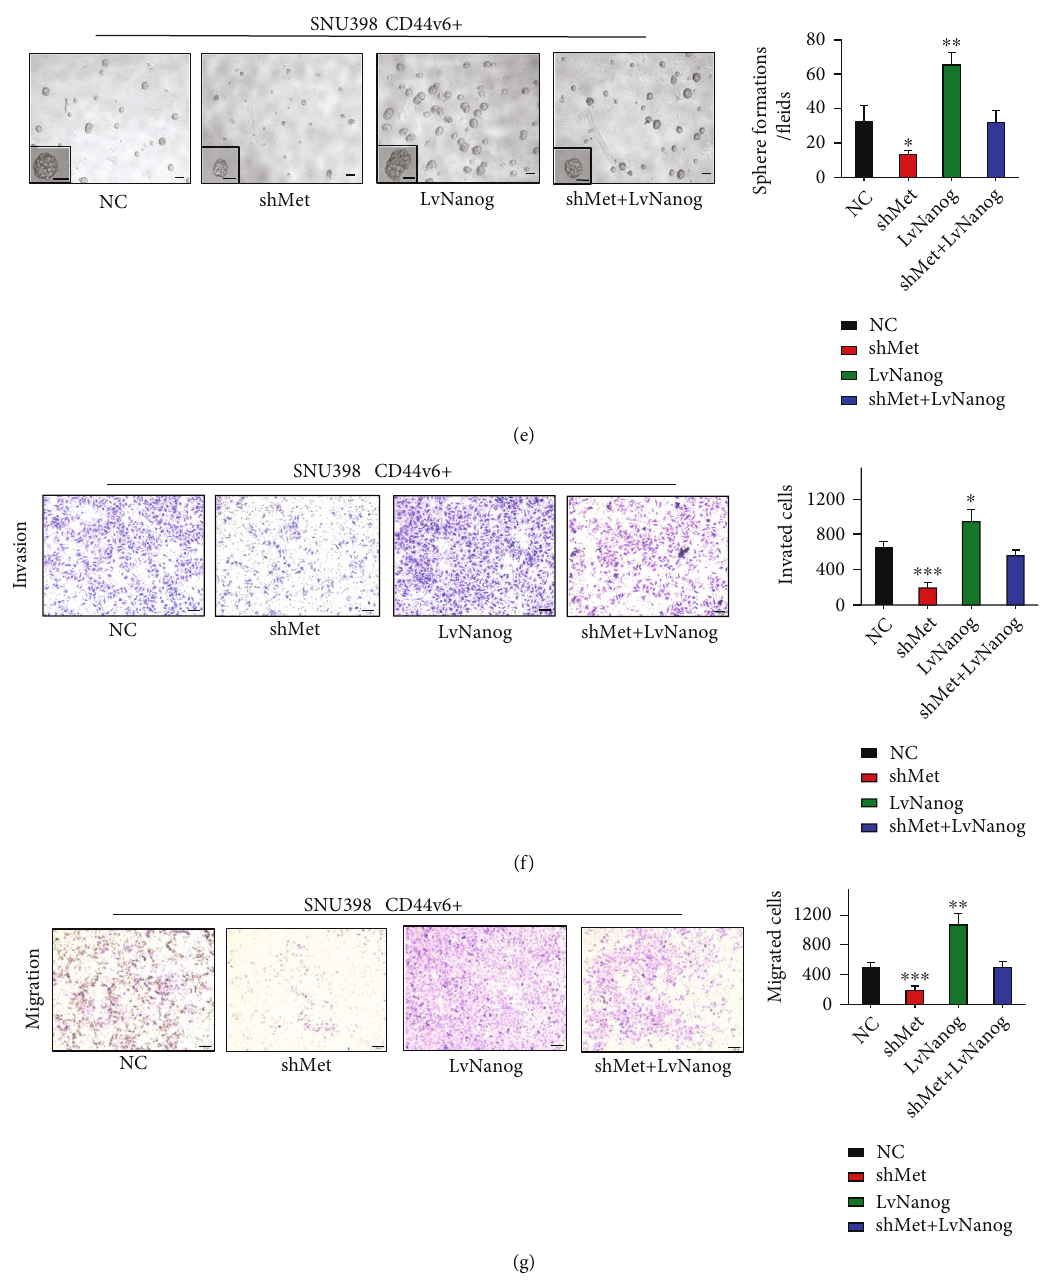
Figure 3: The HGF/MET signaling pathway activates Nanog expression in CD44v6+ HCC cells. (a) Silencing Met decreased the expression of stemness relative genes, including Oct4, Sox2, and Nanog in CD44v6+ SNU-398 cells. β -Actin was used as a normalized control. (b) The expression of EMT-related genes, including Snail1, Slug, and Twist in CD44v6+ SNU-398 cells. β -Actin was used as a normalized control. (c) Western blot showed that silencing Met decreased the expression of Nanog in CD44v6+ cells. But LvNanog did not a ff ect the Met expression. β -Actin was used as a normalized control. (d) 1 × 10 5 of cells were injected into the left lobes of the liver. Bioluminescence signals from Met shRNA groups were weaker than that from corresponding control groups. But overexpressed Nanog could rescue the bioluminescence signals. The central luminescence intensity: 8 : 8e + 7 vs. 1 : 6e + 6 ; ∗ p < 0 : 05 , ∗∗ p < 0 : 01 ; t -test. The representative images of Ki67 immunohistochemistry. Scale bar, 50 μ m. (e) The representative images of spheres and histogram analysis in indicated cells. Scale bar, 200 μ m. (f) and (g) transwell migration and invasion assays showed the knockdown of Met decreased the migration and invasion of CD44v6+ cells, while overexpressed Nanog could rescue the migration and invasion ability. Scale bar, 200 μ m. ∗ p < 0 : 05 , ∗∗ p < 0 : 01 , ∗∗∗ p < 0 : 001 ; t